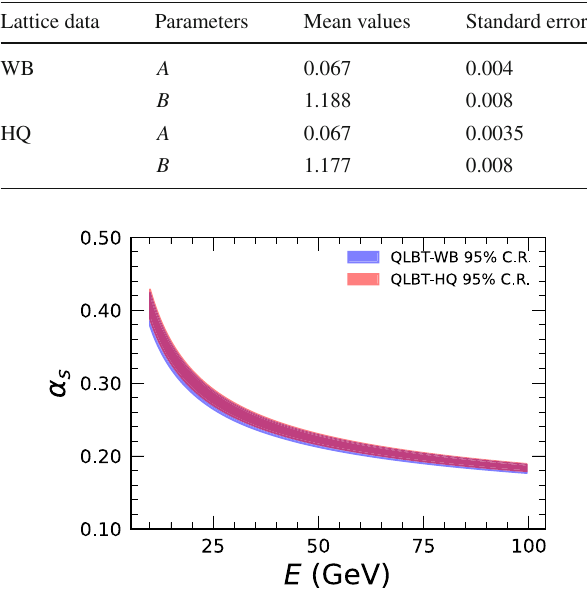
Fig. 7 The energy-dependent running coupling α( E ) obtained from the Bayesian analysis of D meson R AA and v 2 , using two different g ( T ) obtained in Sect. 2 from fitting to WB and HQ lattice QCD data